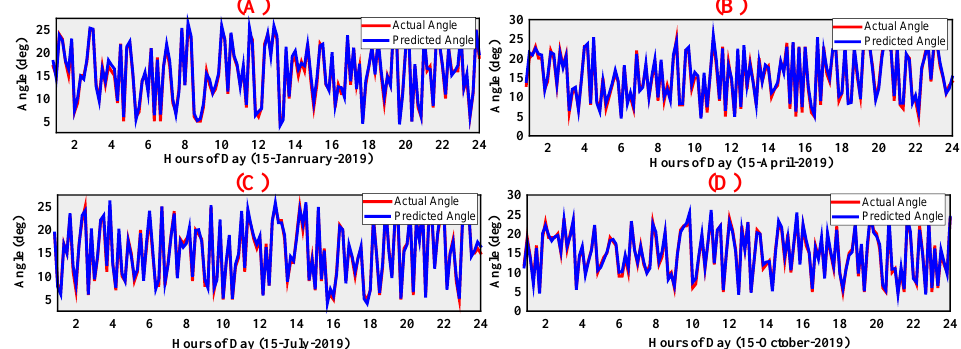
Figure 8. Variation in the angle of attack for one day during ( A ) winter, ( B ) summer, ( C ) spring, and ( D ) autumn.